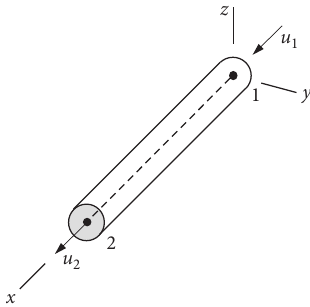
Figure 5: CableSEL coordinate system and 2 active degrees of freedom of the cable finite element.